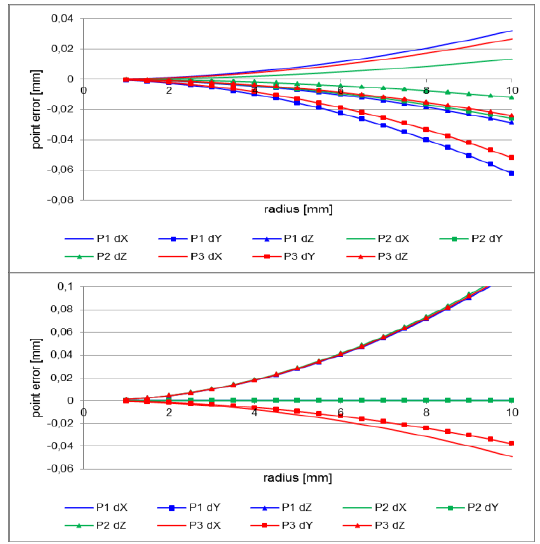
Figure 13: 3D point errors as a function of circular target radius for normal case (left) and convergent stereo case (right) Figure 13 (bottom) shows the 3D coordinate errors as a function of varying target radius in the case of convergent images ( j 1 =– 10°, j 2 =+10°). Here the target plane is parallel to the XY plane of the object coordinate system. For points P1 and P2, which lie in the middle between both cameras ( X =0), only a deviation in